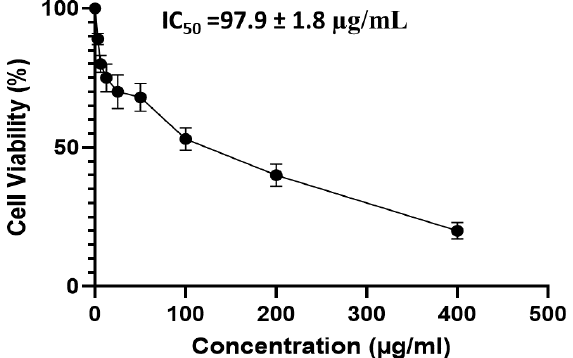
Figure 4. A graph showing cytotoxicity APEE on PBMCs using MTT to determine IC 50 . The results are expressed as mean ± SD as the experiments were performed in three independent triplicates.